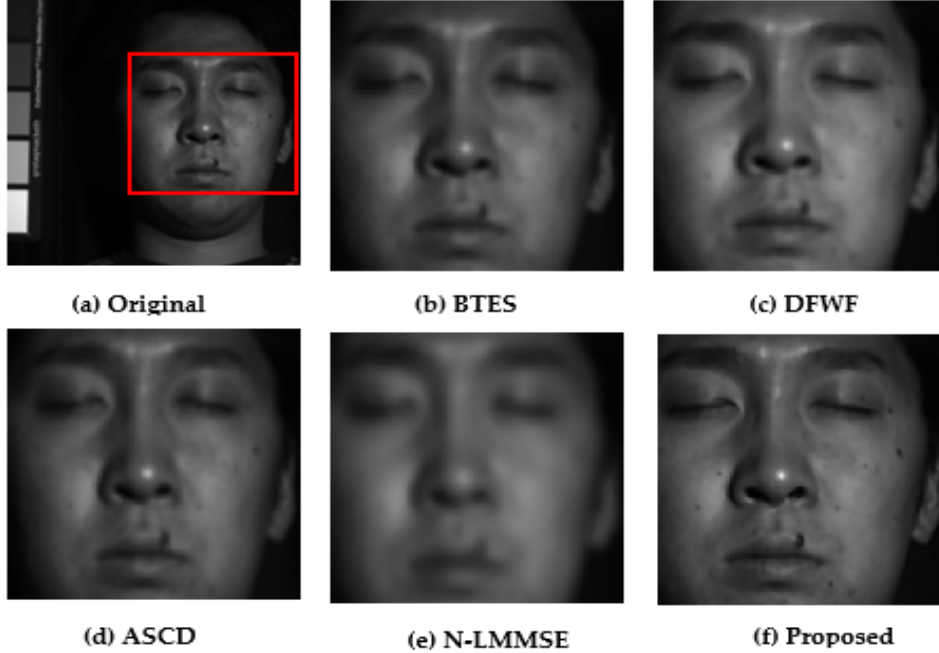
Figure 11. Visual comparison of red band in face image.